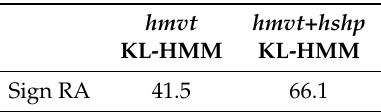
Table 11. Sign RA on the DSGS database of the cross-lingual KL-HMM system depending on the movement ( hmvt ) TSL HospiSign subunits posterior probabilities alone or added to the hand shape features ( hmvt+hshp ).